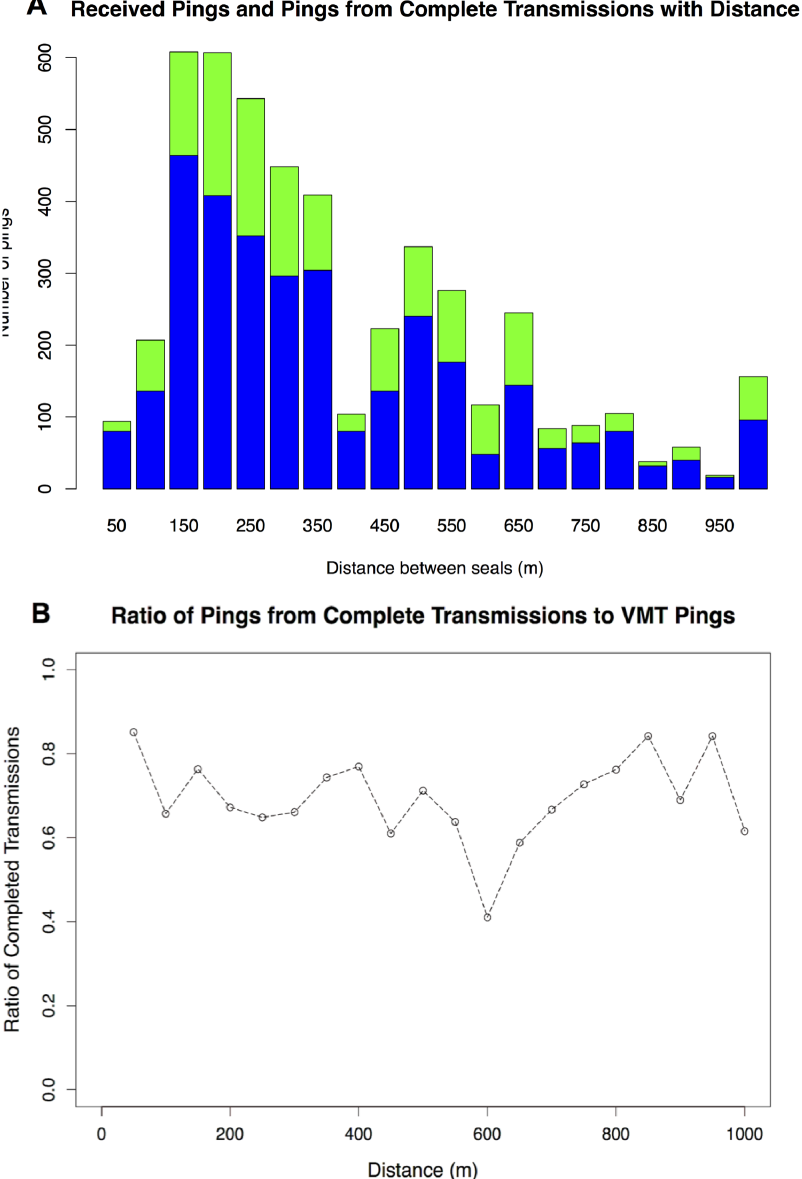
Figure 4. Density and ratio of VMT acoustic pings. A. Density of VMT acoustic pings received (green) and acoustic pings from VMT transmissions (blue) with distance. B. Plot of the ratio of pings from complete transmission to VMT pings